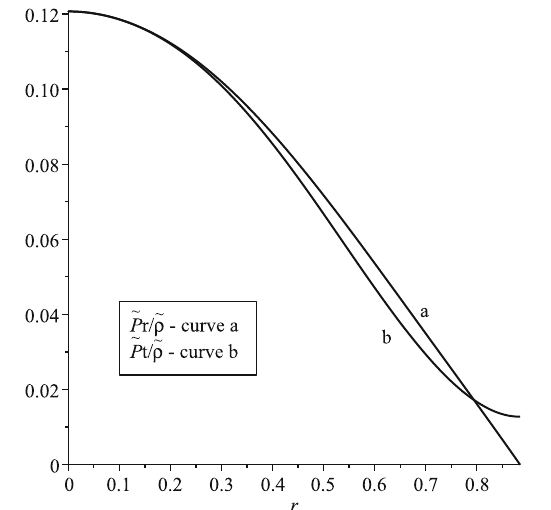
Fig. 5 Dominant energy condition for the solution obtained with the first algorithm with F = 0 from the isotropic Gold III solution